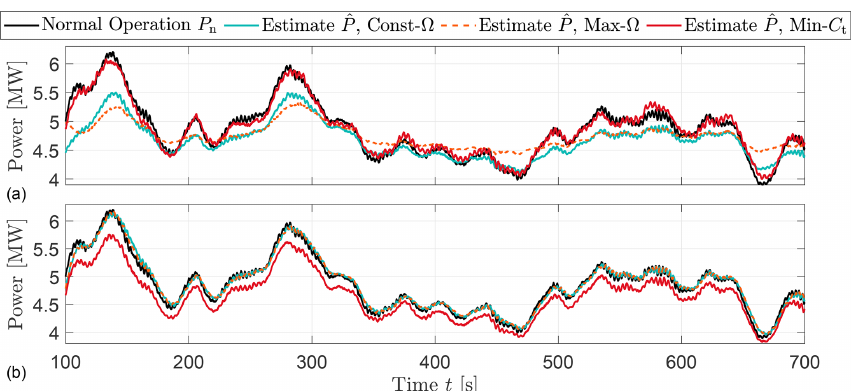
Figure 2. Time series of normal power P n and available power estimation ˆ P based upon various down-regulation strategies. (a) and (b) in- dicate the estimation based on measurements of turbines operating at 40% and 80% of the rated power,